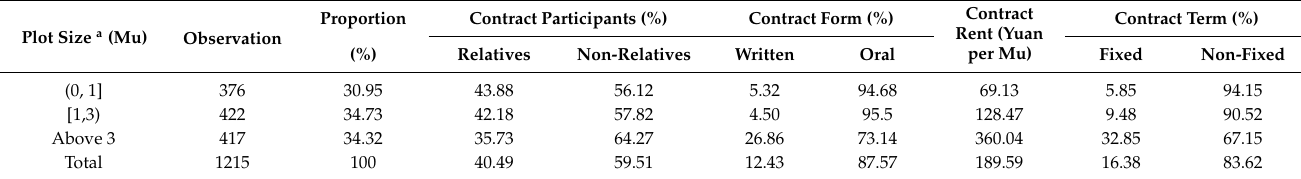
Table 2. The relationships between plot size and farmland contract